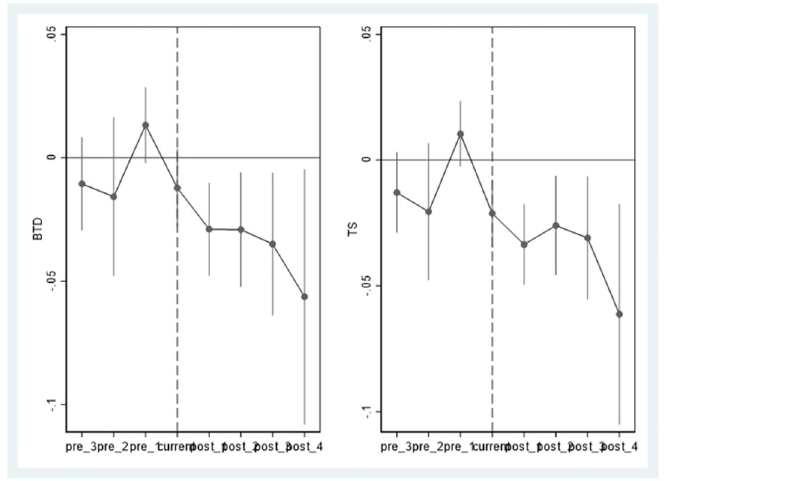
Fig 2. Dynamic effect of stagger